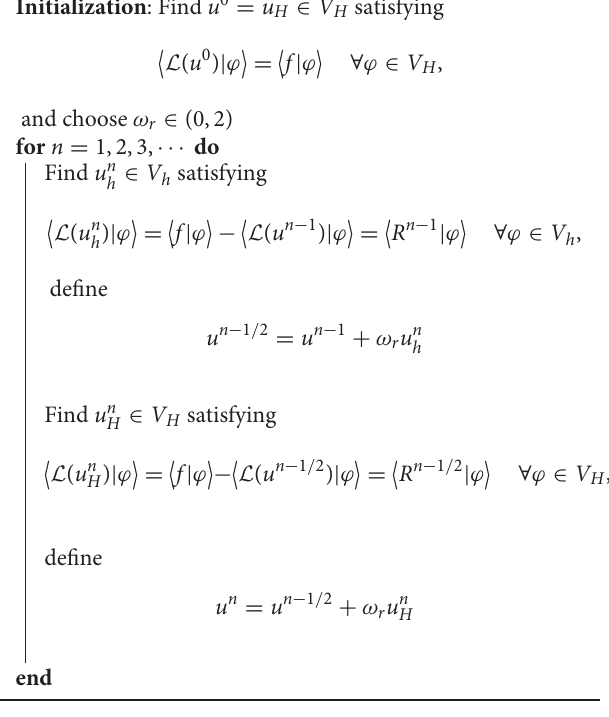
Algorithm 1: Patch algorithm when using only a single